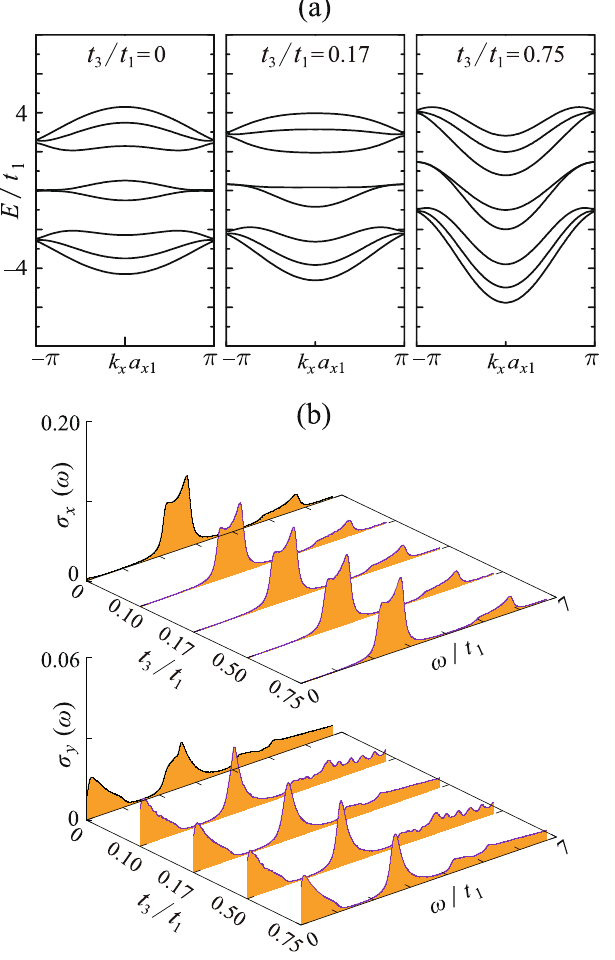
Figure 5. Same as Fig. 4, but for the case of varying t 3 / t 1